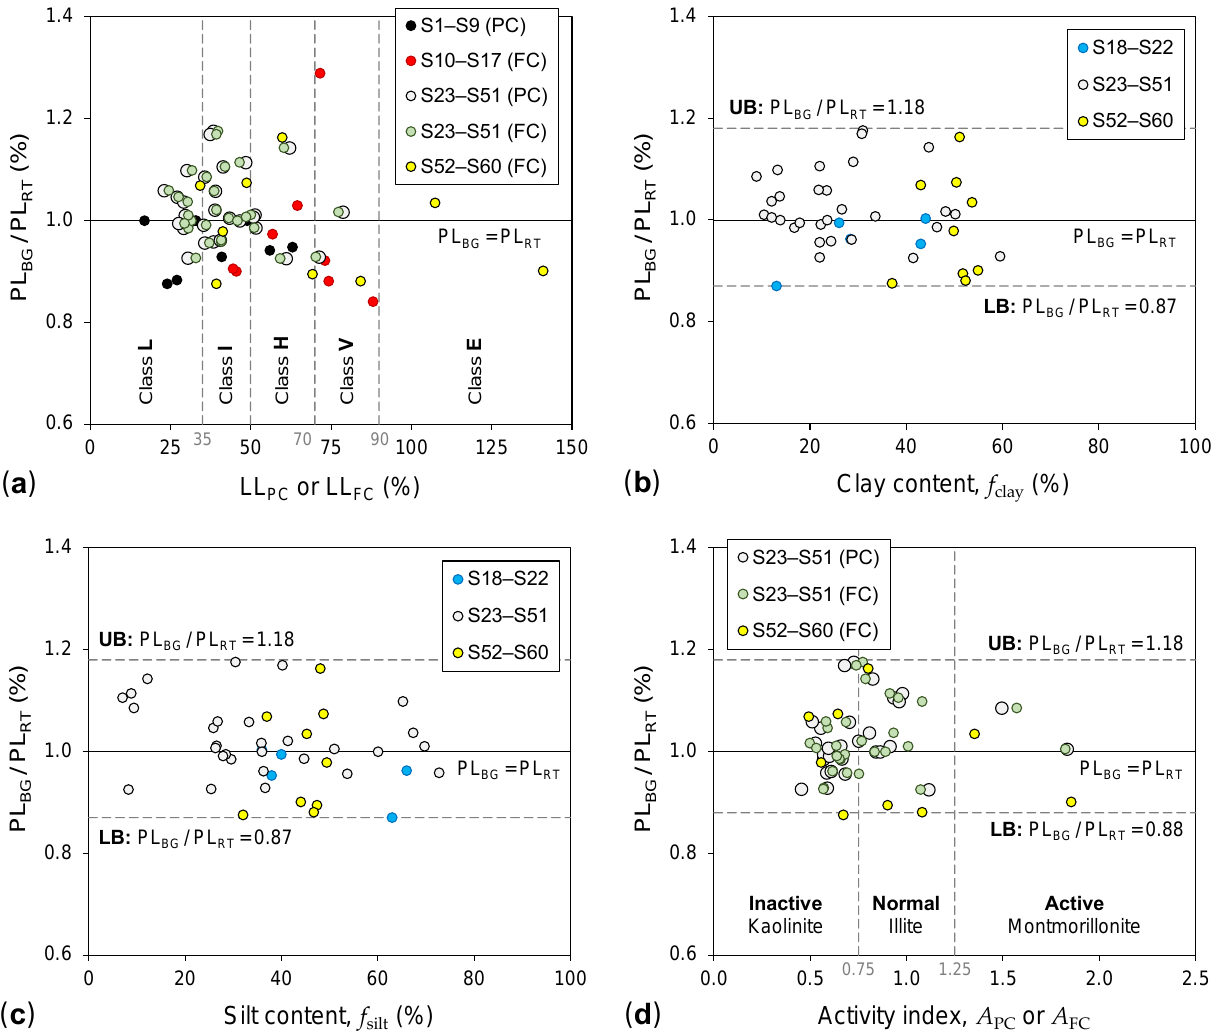
Figure 4. Variations of the PL BG -to-PL RT ratio against fundamental soil properties for the compiled database: ( a ) LL PC or LL FC ; ( b ) f clay ; ( c ) f silt ; and ( d ) A PC or A FC . Note: LB and UB denote lower and upper PL BG /PL RT boundaries, respectively; and L, I, H, V and E represent low, intermediate, high, very high and extremely high plasticity level classes,